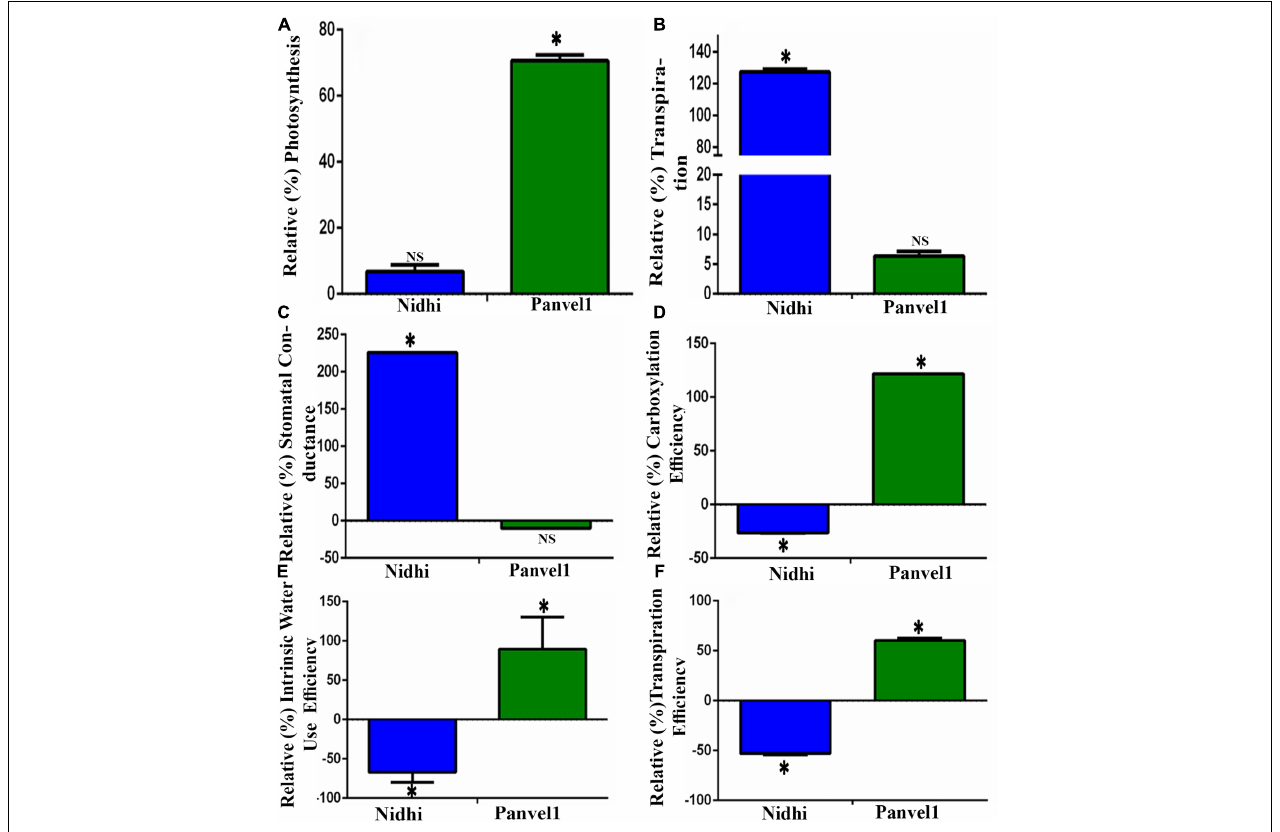
FIGURE 8 | Validation of biological processes: Validation was done using Licor instrument 6400XT (LI-COR, Lincoln, NE, United States) on 21 old days grown plants. Plants were grown in nutrient-depleted soil and fertilized with Arnon Hoagland medium having nitrate as the sole source of N with 15 mM concentration as control while 1.5 mM, was used as a test. Measurement was done in five biological replicates. Percent increase or decrease (relative measurement) for each of the measurements was calculated in low nitrate over normal nitrate. (A) Relative photosynthesis was measured in terms of µ mol (CO 2 ) m − 2 s − 1 . (B) Relative transpiration was measured in terms of mol (H 2 O) m − 2 s − 1 , and (C) Relative stomatal conductance was measured in terms of mol (H 2 O) m − 2 sec − 1 ). (D) Relative carboxylation efficiency was measured in terms of µ mol (CO 2 )/m 2 s 1 /Ci as the ratio of photosynthesis and internal CO 2 concentration, (E) Relative internal water use efficiency was measured in terms of µ mol (CO 2 )/mol (H 2 O), and (F) Relative transpiration efficiency was measured in terms of µ mol (CO 2 )/mmol H 2 O m − 2 s − 1 . The test of significance for low nitrate over normal nitrate for each of the individual bars has been shown as star ( P < 0.05), while NS represents